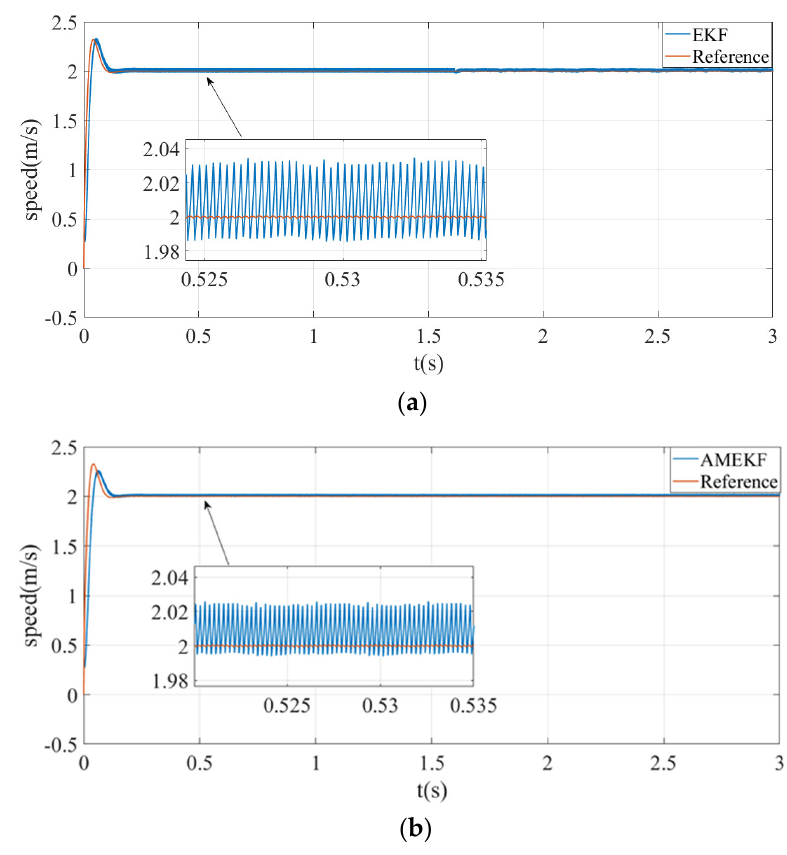
Figure 6. Measured and estimated velocity. ( a ) Actual speed and estimated speed under EKF algorithm. ( b ) Actual speed and estimated speed under AMEKF algorithm.